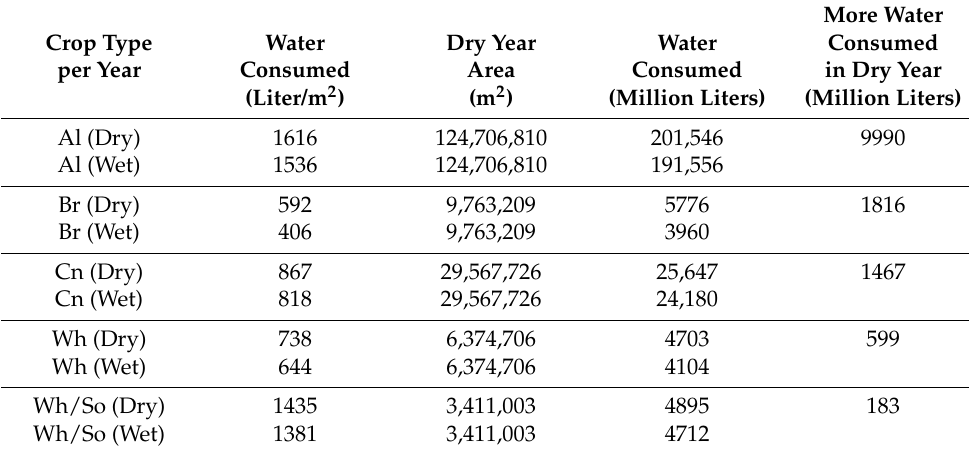
Table 7. Water saving by crops in wet years using the same crop area in both dry and wet years (Al = Alfalfa; Br = Barley; Cn = Corn; Ct = Cotton; Wh = Wheat; So = Sorghum). More Water Crop Type Water Dry Year Water Consumed Consumed Area Consumed in Dry